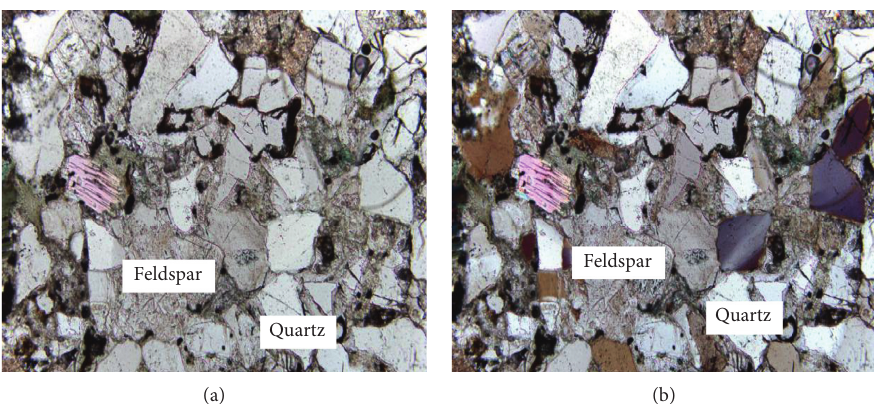
Figure 2: Microstructure of Jurassic sandstone (8x magnification): (a) plane polarized light, and (b) perpendicular polarized light.